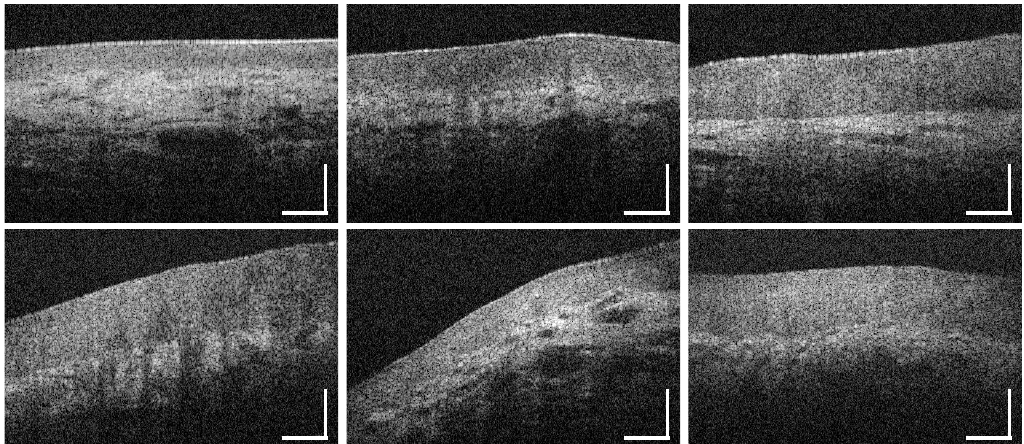
Figure A11. Supplementary intensity-based OCT cross sections of the mucosal tissue of the inner upper lip (MP1, Figure 1). Scale bars: 200 µ m.